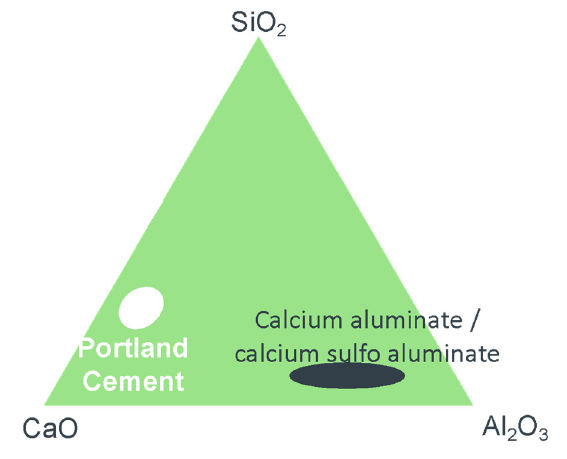
Figure 1. CaO ‐ SiO 2 ‐ Al 2 O 3 phase diagram showing two regions of cementitious phase, Portland cement, containing mainly Calcium Silicates C 3 S and C 2 S and Calcium Aluminate /